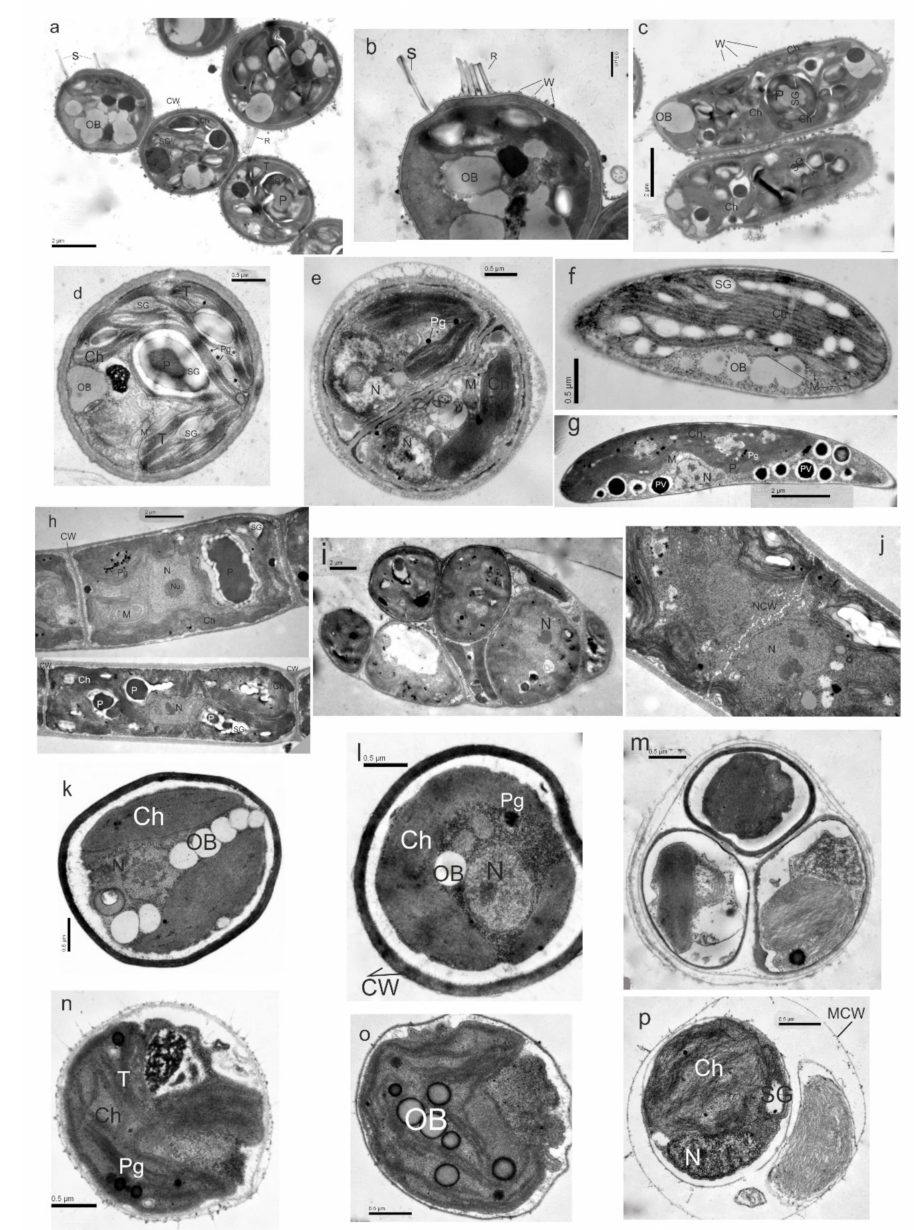
Figure 7. Electron micrographs of strains Desmodesmus sp. TAU-MAC 0910 ( a – c ), Desmodesmus sp. 1817 ( d , e ), Monoraphidium sp. 1210 ( f , g ), Uronema trentonense 0215 ( h – j ), Ava limnothalassea TAU-MAC 2217 ( k – m ), Nomia picochloropsia TAU-MAC 3617 ( n – p ); ( a ): four-celled coenobium with oil bodies and starch grains. ( b ): spines, ribs, and warts. ( c ): a central big pyrenoid surrounded by starch. ( d ): thylakoids of chloroplast arranged in bundles. One central pyrenoid surrounded by starch and accumulation of extra starch grains and lipid droplets (plastoglobuli, Pg) in the chloroplast. ( e ): a mother cell divided into two daughter cells. ( f ): oil bodies and starch grains are present in older cells. ( g ): polyphosphate vacuoles. ( h ): parietal and band-like chloroplast, containing more than one pyrenoid covered with starch grains. ( i ): autosporagium. ( j ): cytokinetic cell forming a new cell wall (NCW). ( k ): aging cell accumulating oil bodies. ( l ): mature cell, chloroplast without pyrenoid. ( m ): aplanosporangium. ( n , o ): mature cells that accumulate plastoglobuli. ( p ): aplanosporangium. Ch, chloroplast; CW, cell wall; M, mitochondrion; NCW, new cell wall N, nucleus; Nu, nucleolus; OB, oil body; Pg, plastoglobuli; P, pyrenoid; PV polyphosphate vacuole; R, ribs; S, spine; SG, starch grain; T, thylakoids; W,